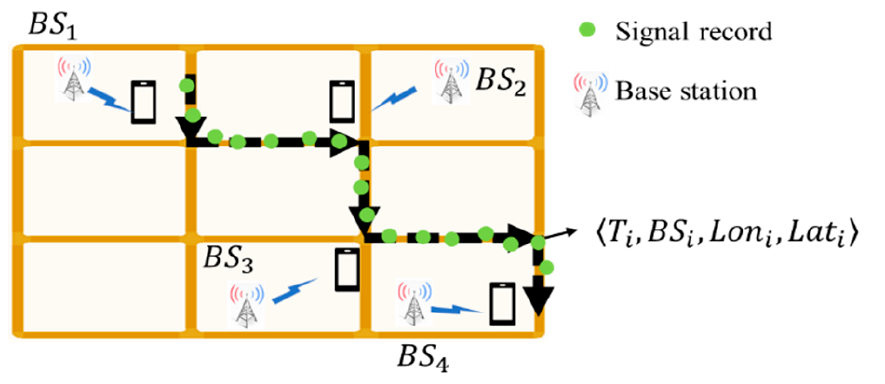
Figure 2. A schematical illustration of the data acquisition process.